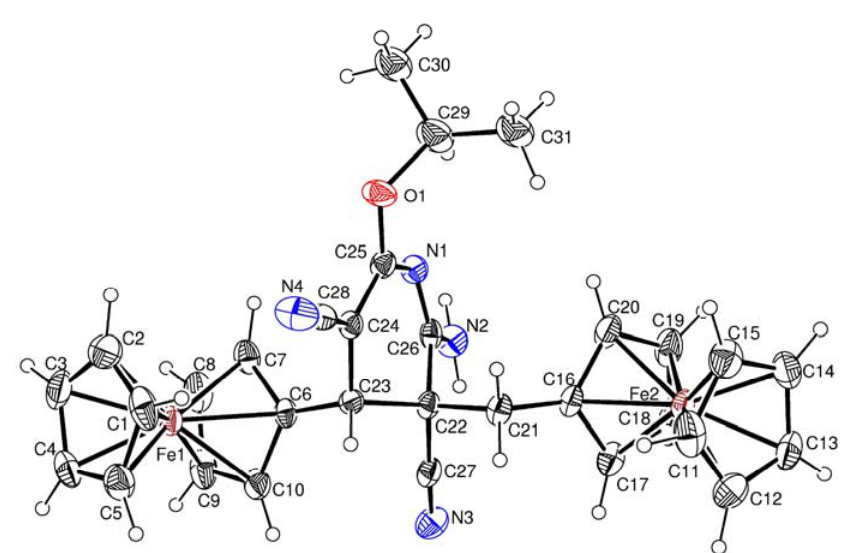
Figure 3. Crystal structure of 4b